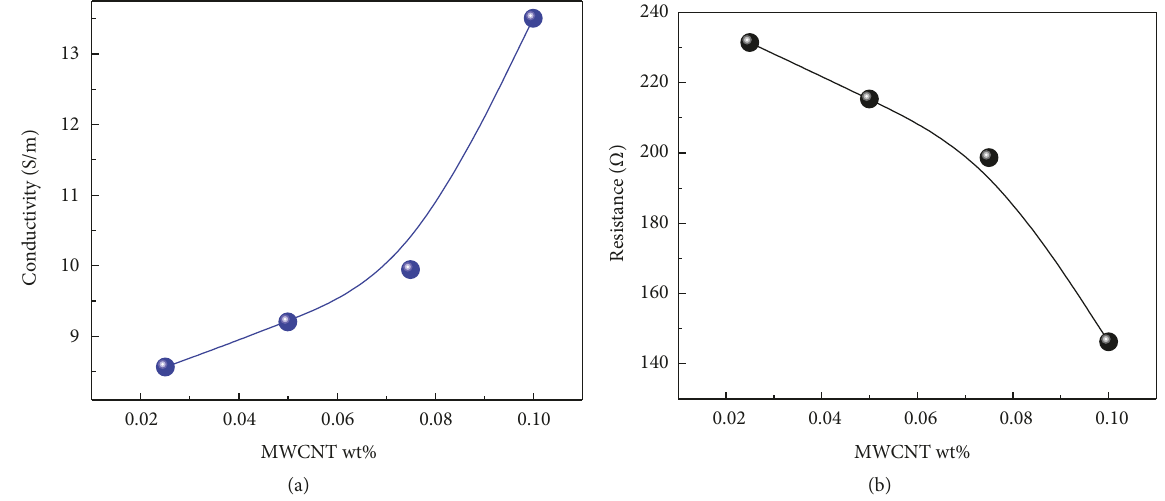
Figure 7: (a) Conductivity of MWCNT-PEDOT: PSS film increases with increasing wt% of MWCNT. (b) Resistance of MWCNT-PEDOT: PSS film decreases with increasing wt% of MWCNT.